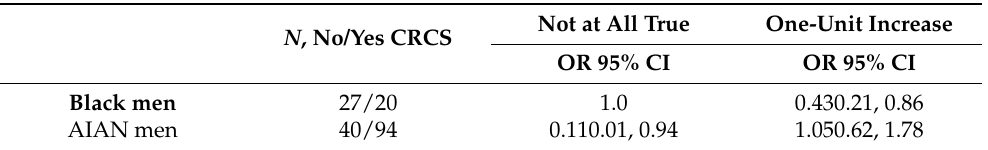
Table A2. Modification table of the effect of negative attitudes toward medical professionals and exams on ever completing a colorectal cancer screening test between Black and AIAN men (smaller adjusted